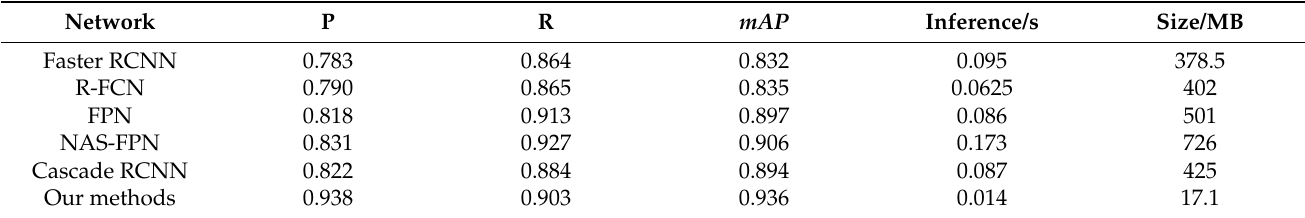
Figure 14. Test accuracy ( a ) and loss ( b ) curves for the proposed method and the yolo family of detection algorithms in the DR datasets. Table 2. Performance of peer defect target detection algorithms on the RR dataset (mainly in the two-stage). Network